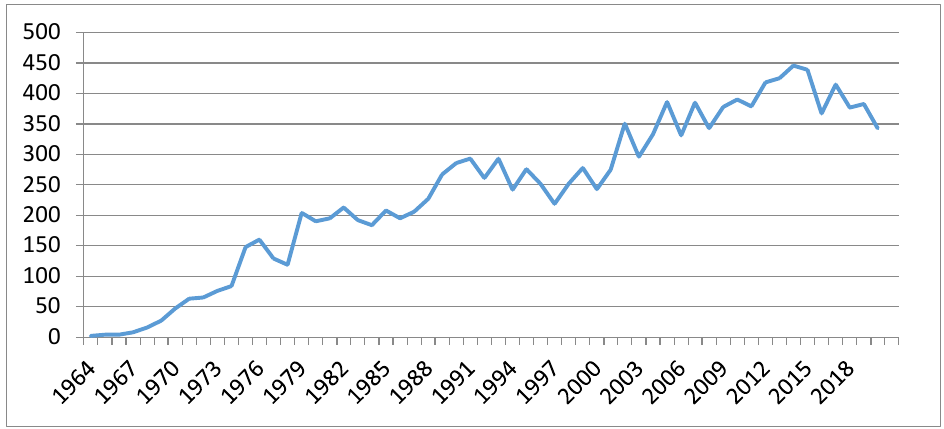
Figure 1. Number of publications on insect sex pheromones appeared in the literature (1964–2020). Table 1. Highly concerned genera on sex pheromones since